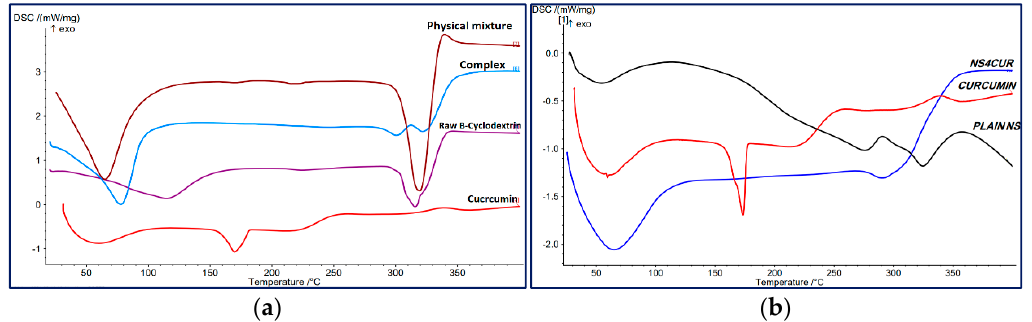
Figure 5. DSC thermograms of ( a ) curcumin- β -cyclodextrin complex; ( b ) curcumin-loaded nanosponges compared to the raw materials.